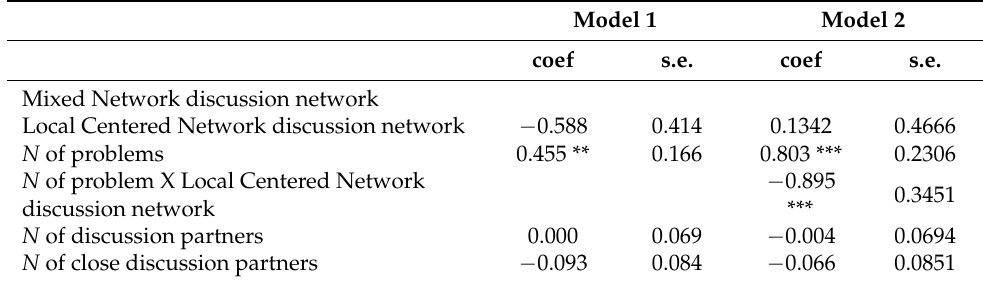
Table 3. Effects of discussion network types on depression